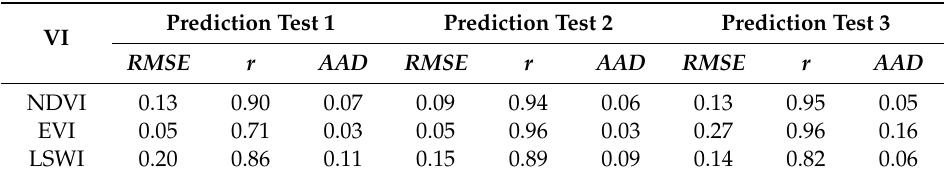
Table 3. Root Mean Square Error ( RMSE ), Correlation Coe ffi cient ( r ), and Absolute Average Di ff erence ( AAD ) between the STARFM-predicted NDVI / EVI / LSWI values and the corresponding Landsat NDVI / EVI / LSWI